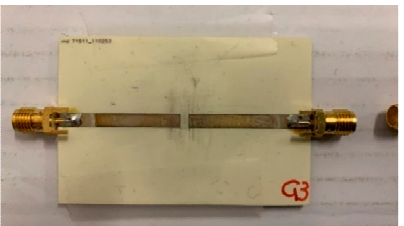
Figure 1. Prototype of the microstrip line with gap without film deposition.